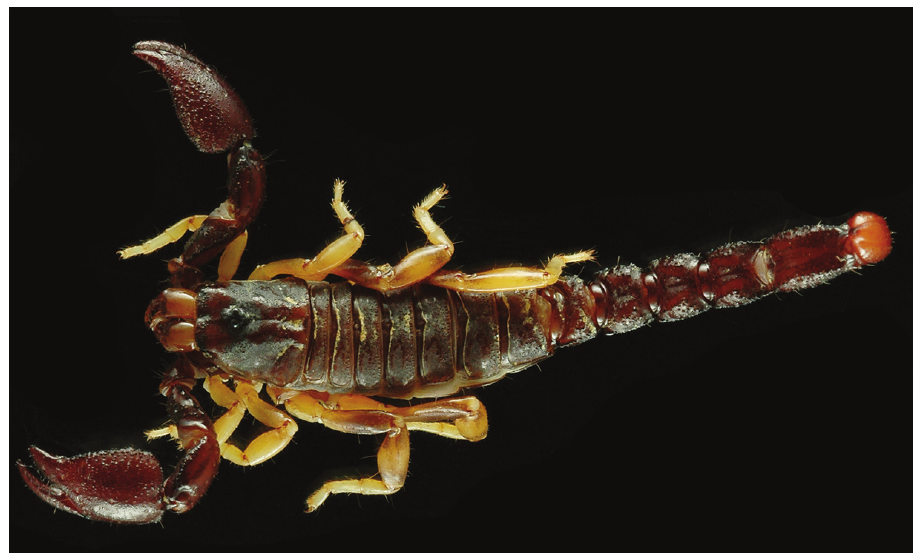
Figure 19. Auyantepuia fravalae , male holotype from Saut Pararé (photo MNHN / E.-A. Leguin).